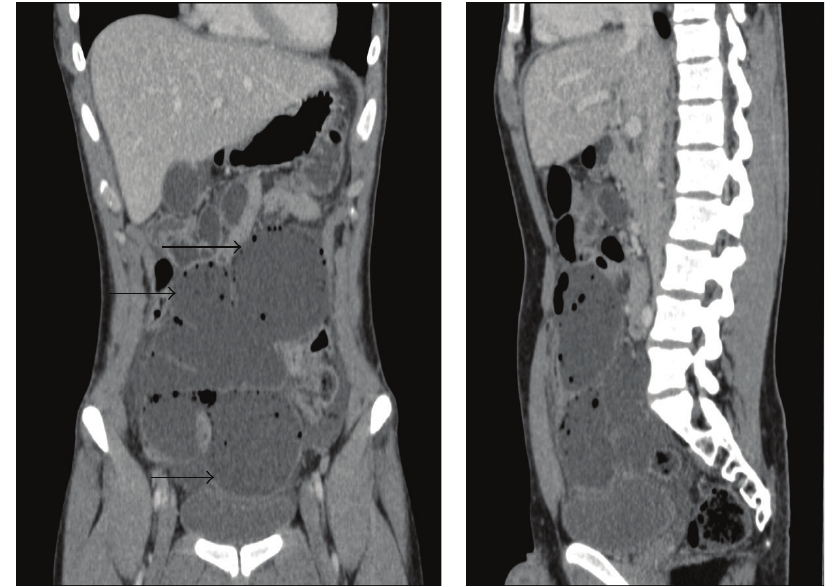
Figure 2: CT scan appearance of the small bowel hamartoma (large diverticula